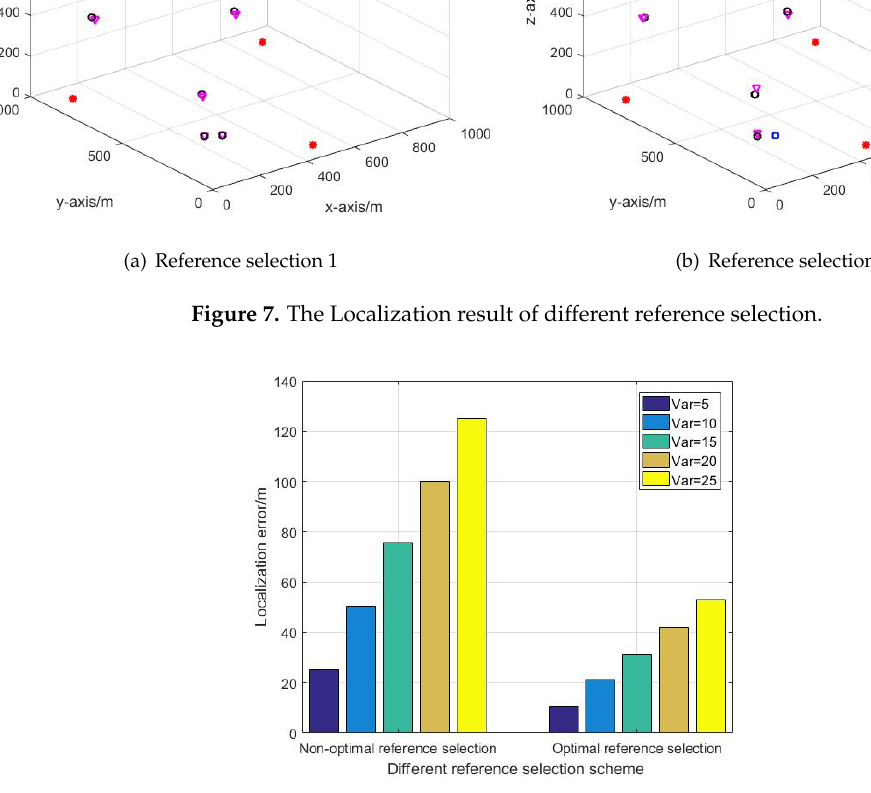
Figure 8. The comparison of localization error between different reference selection